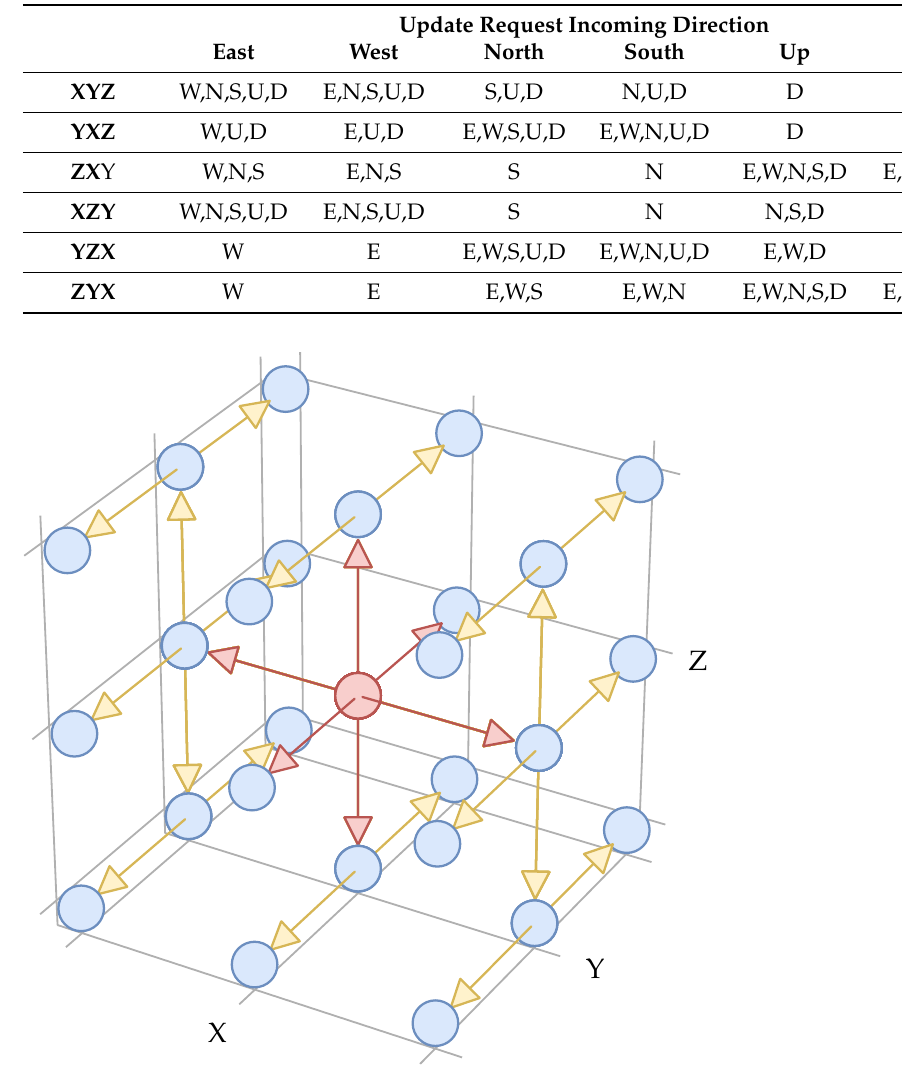
Table 2. Three dimensional update request propagation: output directions depends on the input direction and the current propagation mechanism.